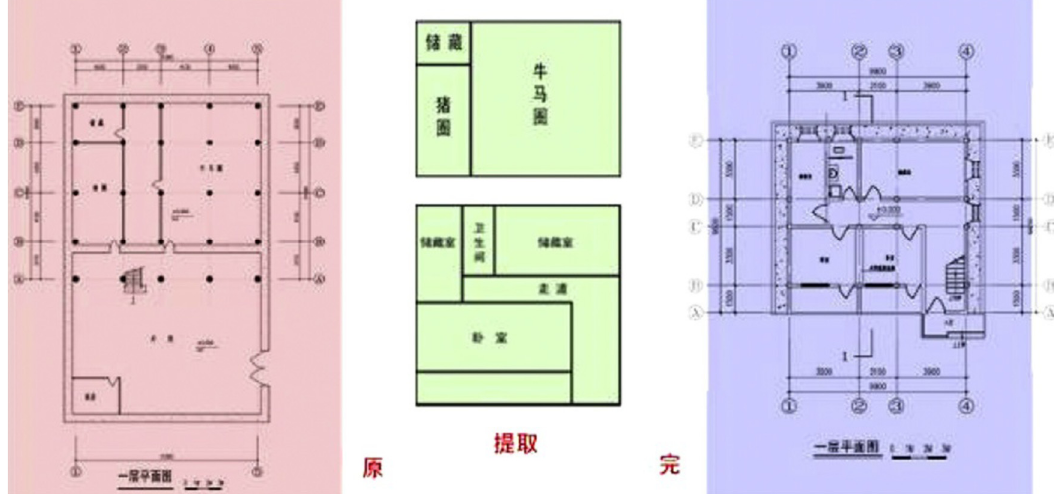
Fig. 6. Reconstruction